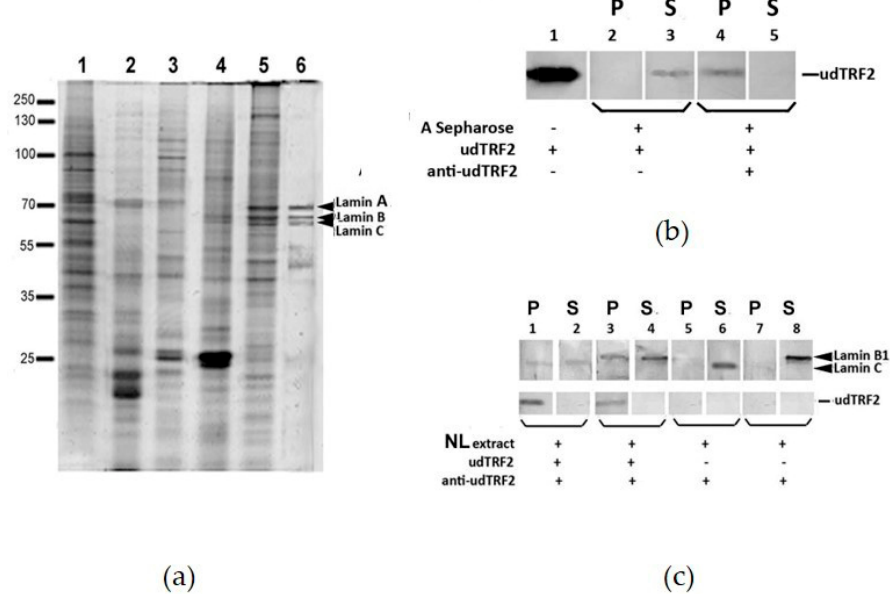
Figure 3. ( a ) Nuclear lamina (NL) purification and extraction (12% SDS-PAGE, CBB). Lane 1, soluble fraction after Triton; lane 2, soluble fraction after nuclease; lane 3, soluble fraction after LS buffer; lane 4, soluble fraction after HS buffer; lane 5, nuclear matrix (NM) precipitate; lane 6, NL extract with lamins A, B, C marked with arrows. Mr of marker indicated on the left. ( b ) udTRF2 AB evaluation. Lane 1, recombinant udTRF2 protein loaded; lane 2, control sample without anti-udTRF2 AB, Sepharose eluate; binding absent; lane 3, sample without anti-udTRF2 antibodies, supernatant, binding absent; lane 4, sample with anti-udTRF2 antibodies, Sepharose eluate, binding present; lane 5, sample with anti-udTRF2 antibodies, supernatant, binding present. P and S, pellet and supernatant from protein A Sepharose column, respectively. The input for each experiment is shown underneath and underlined with brackets. Anti-TRF2 AB (ab4182, Abcam) was used for Western blotting. ( c ) CoIP (co-immunoprecipitation) results analyzed with anti-lamin C and B1 ABs in the upper row and with TRF2 AB in the lower row. P and S, pellet and supernatant from protein A Sepharose column, respectively. The input for each experiment is shown underneath the brackets. Lamin positions are marked by arrows; udTRF2 position is marked by a dash.